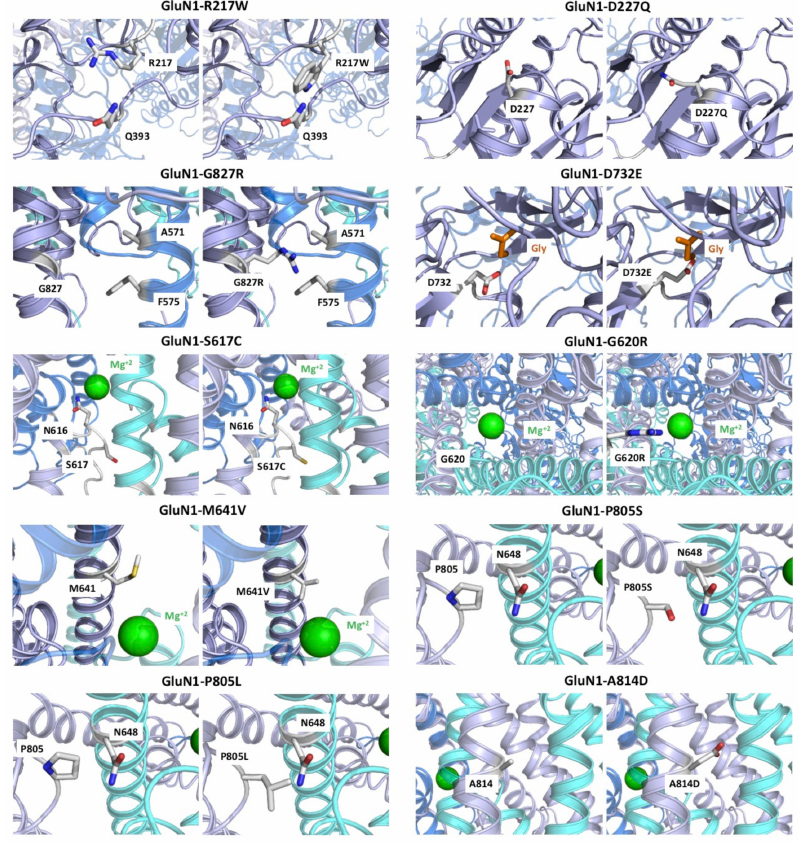
Figure 2. NMDAR structure, composed of two GluN1 subunits (in grey and purple), one GluN2A (cyan), and one GluN2B (blue) subunit. Variants R217W, D227H, G827R and E834Q affect the folding of the protein. D732E variant avoids the binding of the coagonist glycine. S617C, M641, G620R, P805L, P805S, A814D and M181V affect the channel properties. Glycine is shown in orange and magnesium is shown in